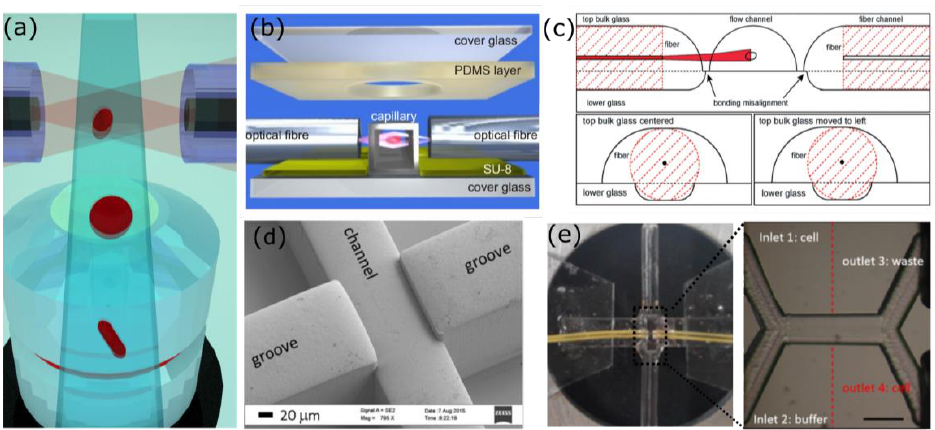
Figure 3. Panel ( a ) shows a scheme of the dual beam optical manipulation approach, with optical fibers used to deliver light to the microfluidic channel. Panels ( b ) to ( e ) show different devices for particles trapping and stretching. In panel b the scheme of the Assembled Optical Stretcher is reported (image reproduced with permission from [70]). Panel ( c ) shows the design proposed by Faigle et al., constituted by two asymmetrically etched substrates [71], published by the Royal Society of Chemistry. Panel ( d ) shows the disposable version of the Optical Stretcher (OS) proposed by Matteucci et al. (reproduced from [72]). Panel ( e ) reports the picture and the microscope image of the monolithic device presented by Yang et al. fabricated by FLICE (reproduced from [73] with permission from the Royal Society of Chemistry). Red traced lines indicate the waveguides position, scale bar is 100 µm.